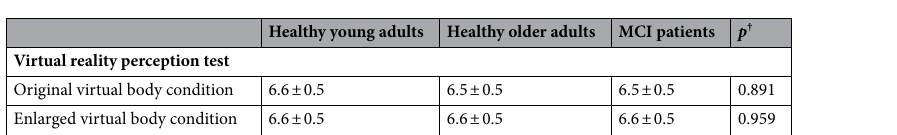
Table 3. The sense of body ownership by group in each virtual reality perception test condition. Values are expressed as means ± SDs. † ANOVA analysis, healthy young adults v. healthy older adults v. MCI patients.